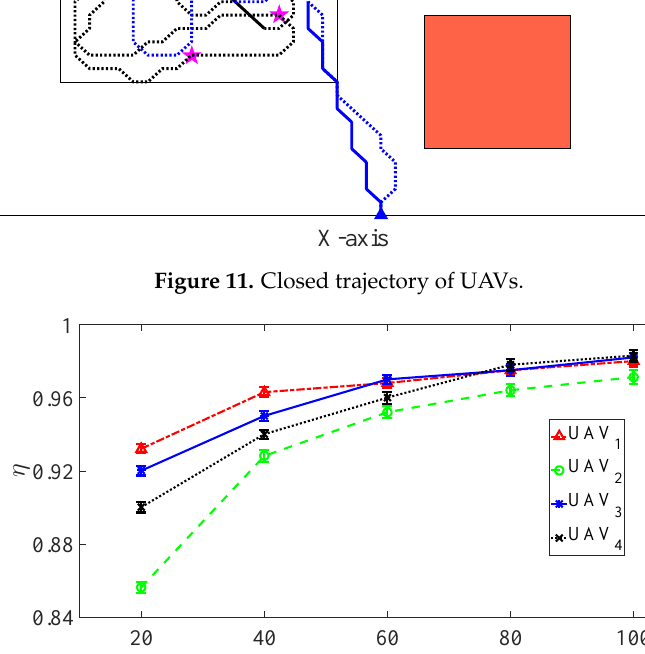
Figure 12. Range utilization of